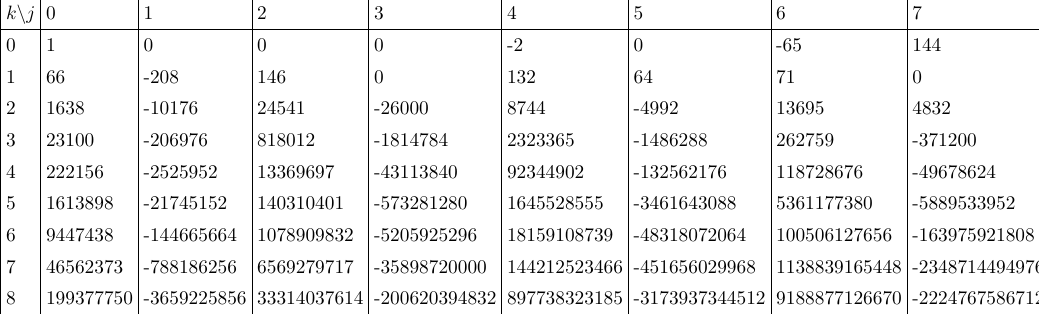
Table 60. Table of b jk coe(cid:14)cients for h SO(12) a